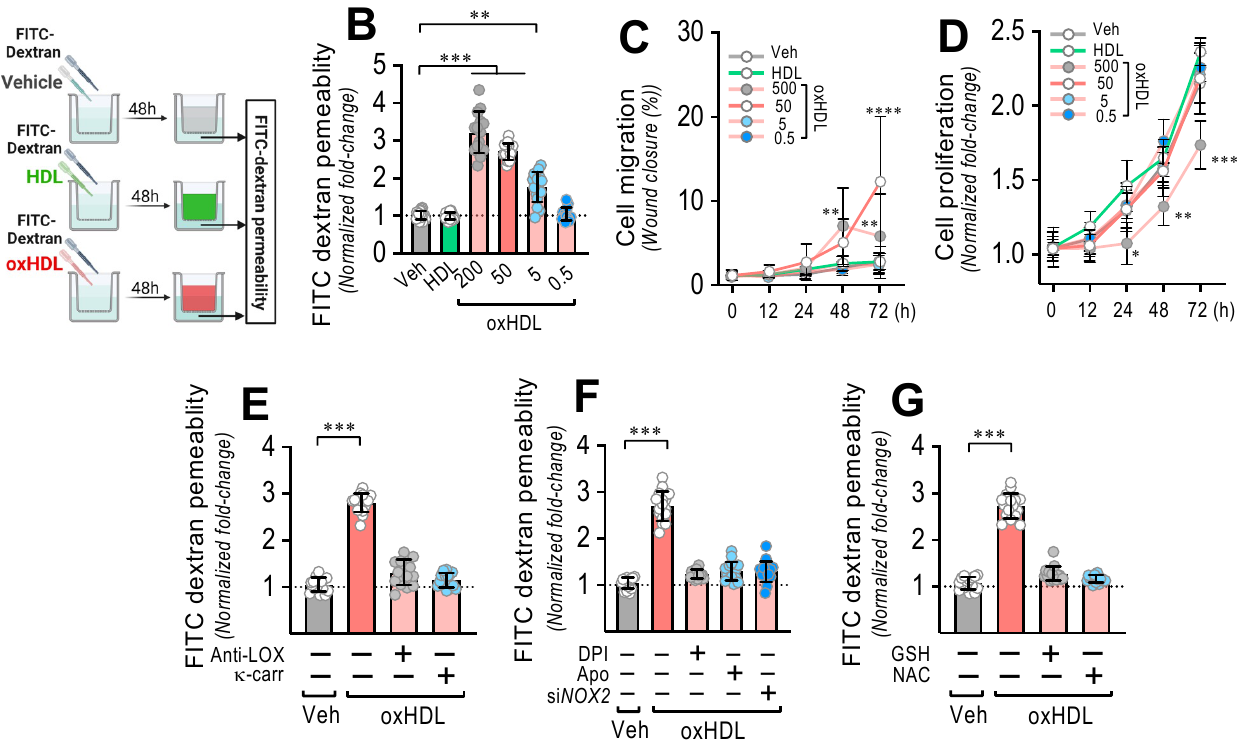
Figure 3. OxHDL induces endothelial hyperpermeability through the LOX-1/NOX-2/ROS pathway. ( A ) Experimental strategy for in vitro oxHDL induces endothelial hyperpermeability determination. Endothelial monolayer was cultured in the upper well in transwell plates and exposed to vehicle, HDL, and oxHDL for 48 h, and FITC-dextran was added to determine permeability in the lower well. ( B ) ECs were exposed to vehicle, HDL (50 µ g/mL), and oxHDL (0.5, 5, 50, 500 µ g/mL) for 48 h, and endothelial permeability to FITC-dextran was measured. (N = 8). ( C , D ) Migration ( C ) and cell proliferation ( D ) assay in ECs treated with vehicle, HDL (50 µ g/mL), and oxHDL (0.5, 5, 50, 500 µ g/mL) for 0, 12, 24, 48, and 72 h. (N = 16). ( E ) ECs were exposed to vehicle and oxHDL 50 µ g/mL for 48 h in the absence or presence of the anti-LOX-1 neutralizing antibody (Anti-LOX, 1:50), and the LOX-1 blocker κ -carrageenan ( κ -carr, 250 µ g/mL) and endothelial permeability to FITC-dextran was measured. (N = 16). ( F ) ECs were exposed to vehicle and oxHDL 50 µ g/mL for 48 h in the absence or presence of the NOX inhibitors DPI (10 µ M) and apocynin (Apo, 10 mM), and against NOX-2 (siNOX-2) or non-transfected for 72 h, and then, cells were exposed to vehicle and oxHDL 50 µ g/mL for 48 h, and endothelial permeability to FITC-dextran was measured. (N = 16). ( G ) ECs were exposed to vehicle and oxHDL 50 µ g/mL for 48 h in the absence or presence of glutathione (GSH, 1 mM) and N-Acetylcysteine (NAC, 5 mM), and endothelial permeability to FITC-dextran was measured. (N = 16). Statistical differences were assessed by one-way analysis of variance (ANOVA) (Kruskal–Wallis) followed by Dunn’s post hoc test, and by two-way ANOVA followed by Dunnett’s post hoc test for C and D. *, p < 0.05; **, p < 0.01; ***, p < 0.001; ****, p < 0.0001. Results are expressed as the mean ±